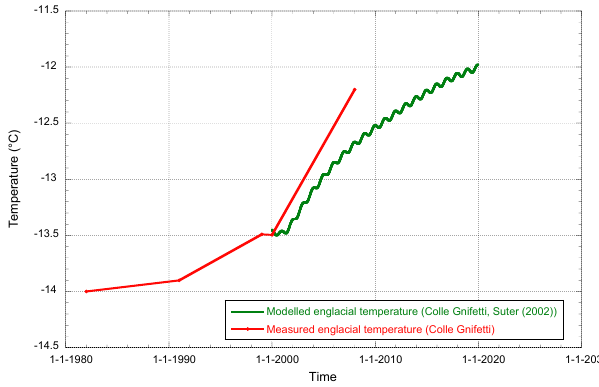
Fig. 13. Modelled englacial temperatures in 18m depth for the years 2000 to 2020 assuming an increase of air temperature of 0.45 ◦ C until 2020 based on a study by Suter (2002) compared with the measured englacial temperature in 20m depth since 1982 (the used temperature measurements were CG82-1/82, CG91-A/91, CG99-2/99, CG00-1/00,